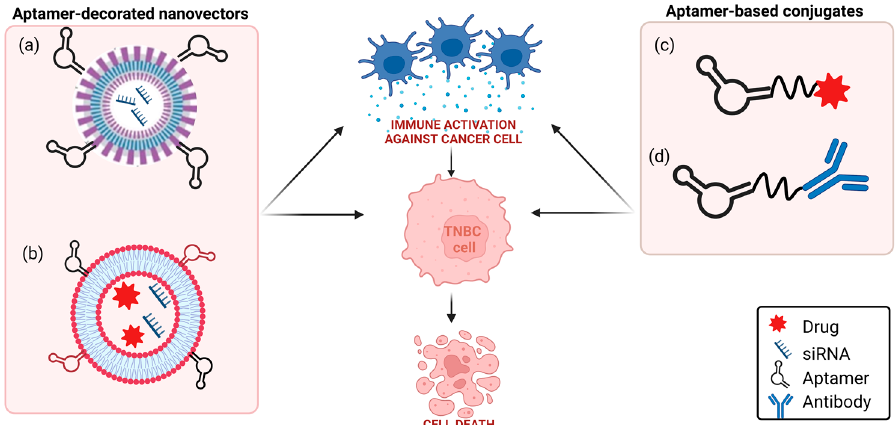
Figure 5. Schematic representation of aptamer-based strategies to block PD-1/PD-L1 axis in TNBC. ( a ) TNBC aptamer-decorated nanoparticles loaded with anti-PD-L1 siRNA; ( b ) anti-CD44 and anti- PD-L1 aptamer-decorated liposomes loaded with both doxorubicin and anti-IDO1 siRNA; ( c ) anti- PD-L1 aptamer conjugated to paclitaxel; ( d ) anti-EGFR aptamer covalently linked to anti-PD-L1 or anti-CTLA-4 mAbs (see text for details). Created with BioRender.com (accessed on 2 March 2023).